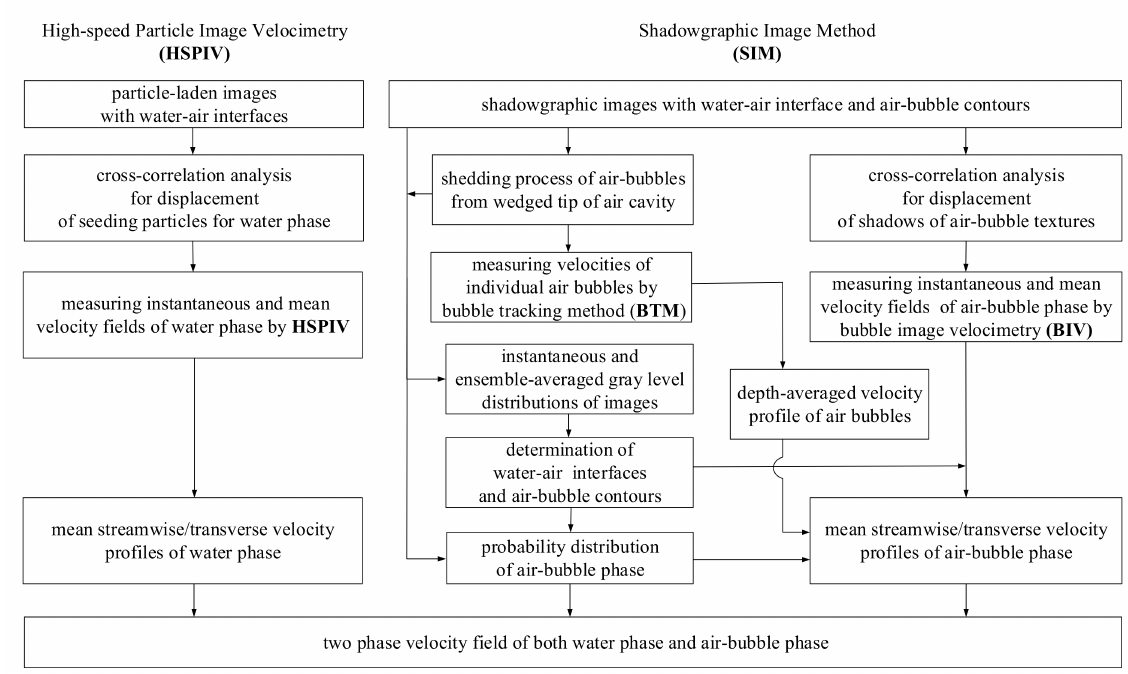
Figure 3. A systematic frame structure outlined for different roles played and distinct targets aimed by HSPIV, SIM, BTM, and